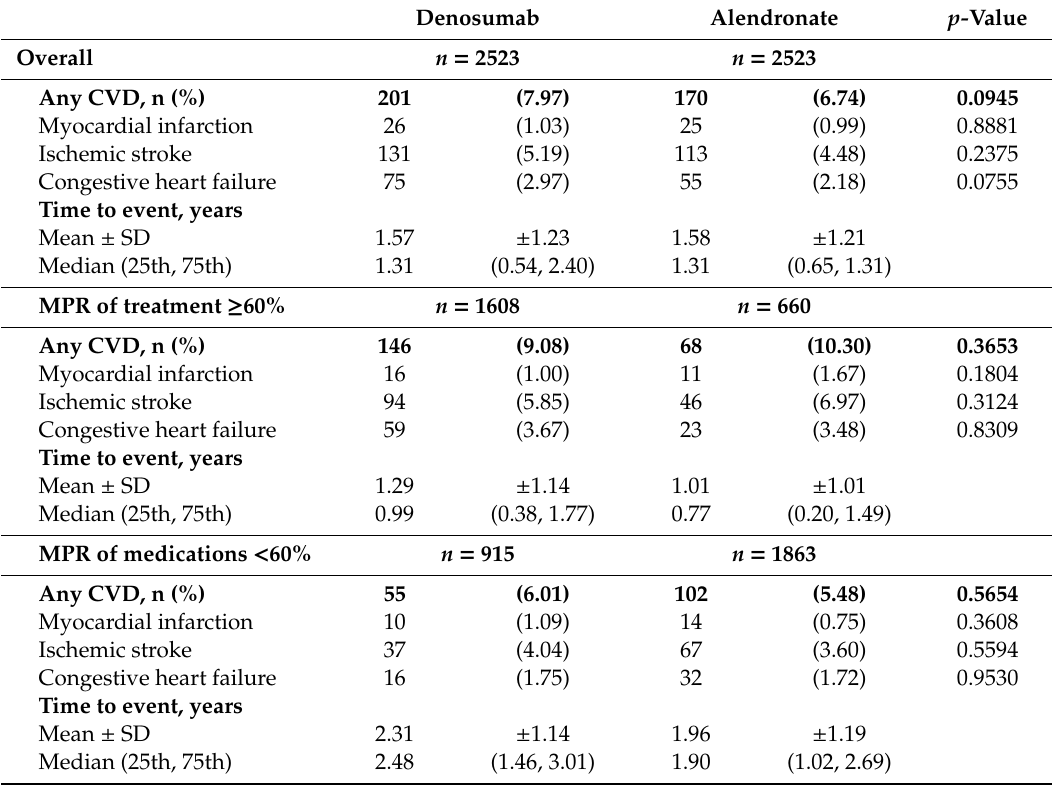
CVD: cardiovascular disease; MPR: medication possession